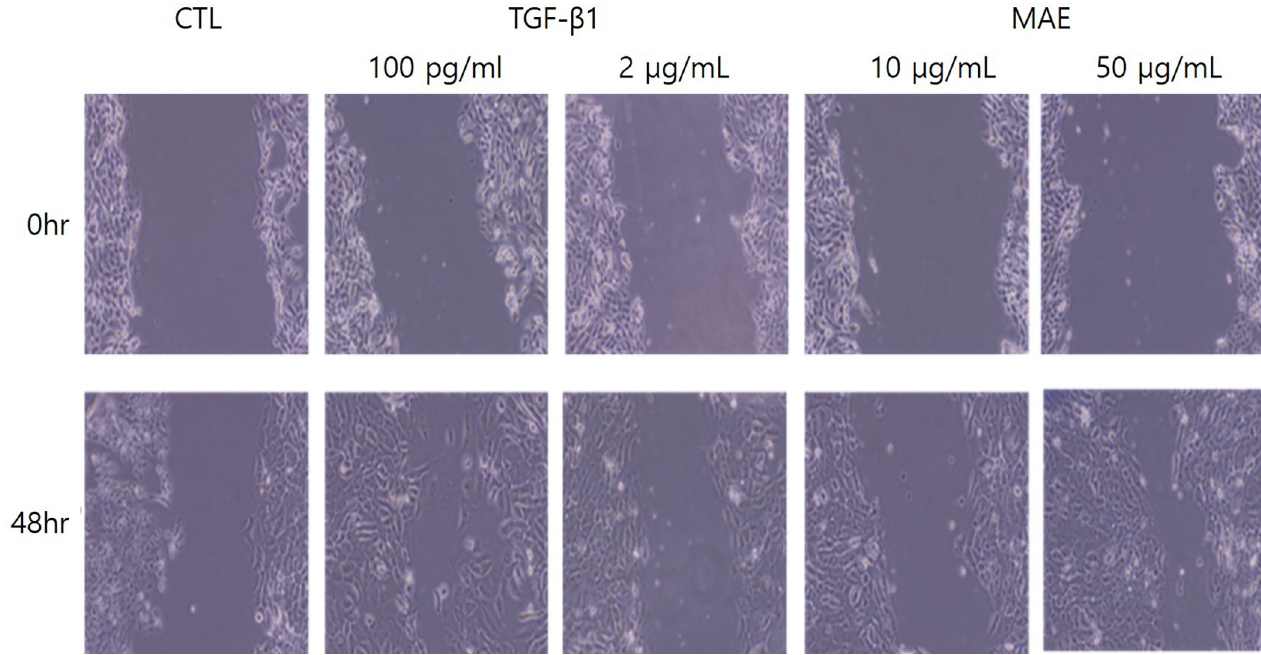
Fig 1. HaCaT cell migration assay. HaCaT cell migration was measured with a wound scratch assay. Treatment with Melia azedarach extract (MAE, 50 μ g/ mL) showed a scratch recovery–promoting effect comparable to that of the positive control TGF- β 1 (100 pg/mL). The wound healing efficacy of MAE was confirmed to have an activity equal or superior to that of TGF- β 1, which is known to have a conventional wound healing effect.